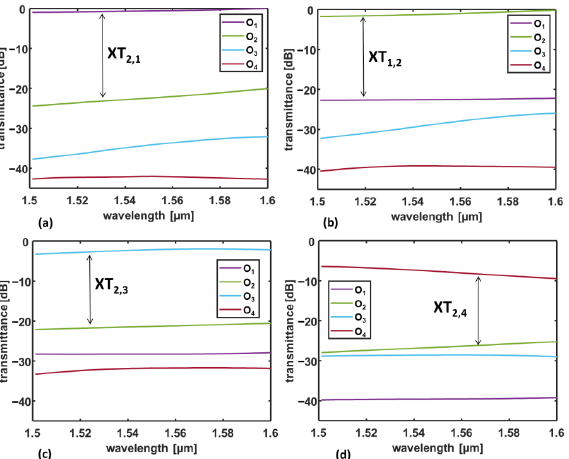
Figure 3. Transmittance in dB, calculated as a function of the wavelength, at the receiving OPAs, i.e., O 1 , O 2 , O 3 , and O 4 , when the transmitting OPA I 1 is excited with phase shifts: ( a ) α = 0°, ( b ) α = 51.4°, ( c ) α = 102.8°, and ( d ) α = 154.2°. The simulated device exploits reconfigurable OPAs made of N = seven taper antennas with a taper length L T = 2 μm. The link distance is d link = 70 μm, and the UV26 cladding thickness is t = 3.78 μm.